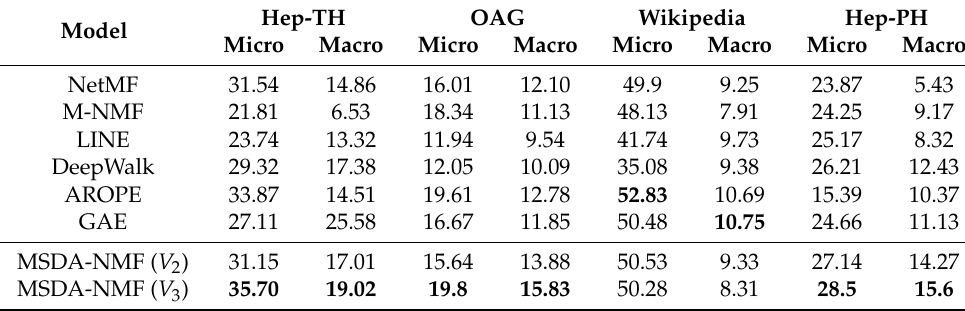
Table 3. Performance evaluation of multi-label